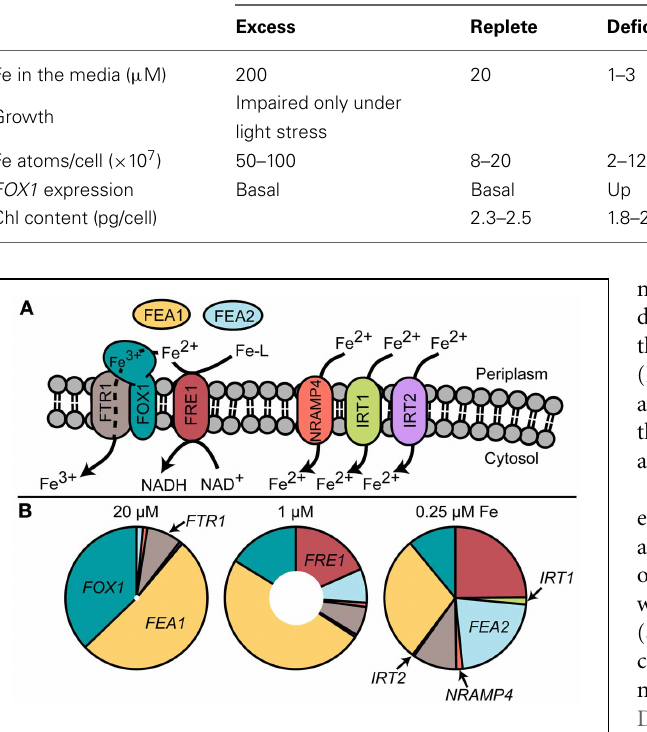
FIGURE 2 | (A) Known and putative iron uptake pathways in Chlamydomonas and (B) transcript abundance of uptake components estimated by RNA-Seq (Urzica et al., 2012). The inner white circles represent total transcript abundance relative to 0.25 µ M iron.